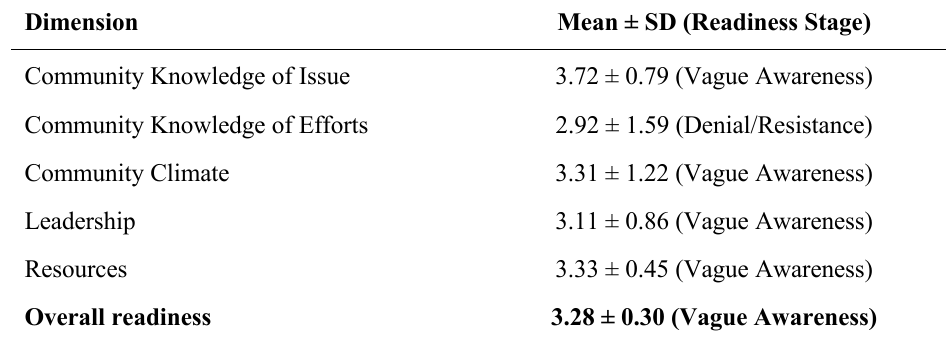
Table 3. Domain specific and overall community readiness